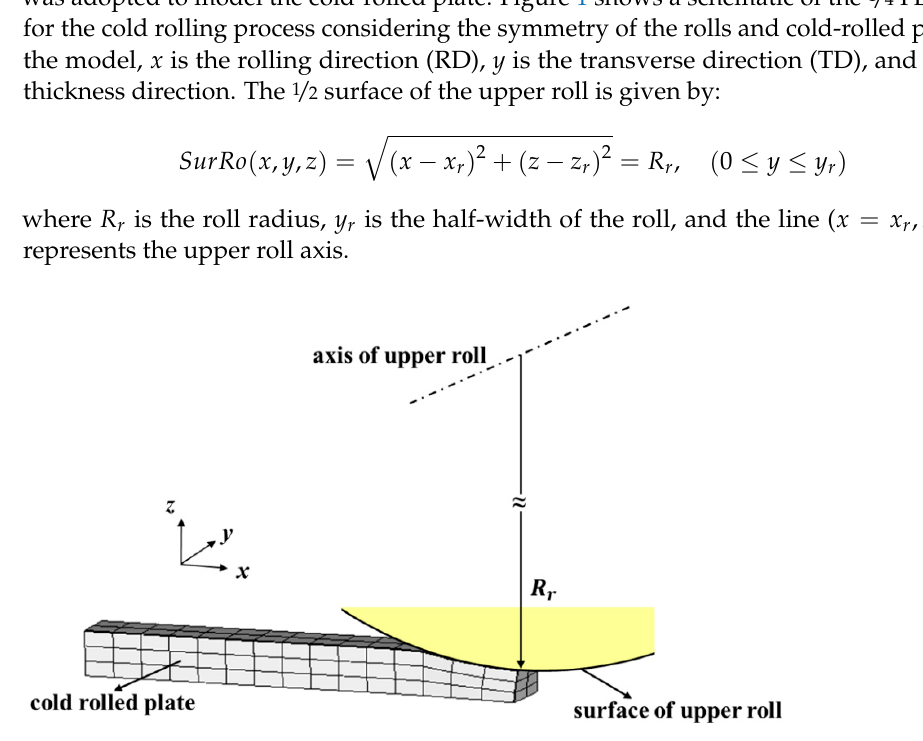
Figure 1. Schematic of the ¼ FE model for the cold rolling process.